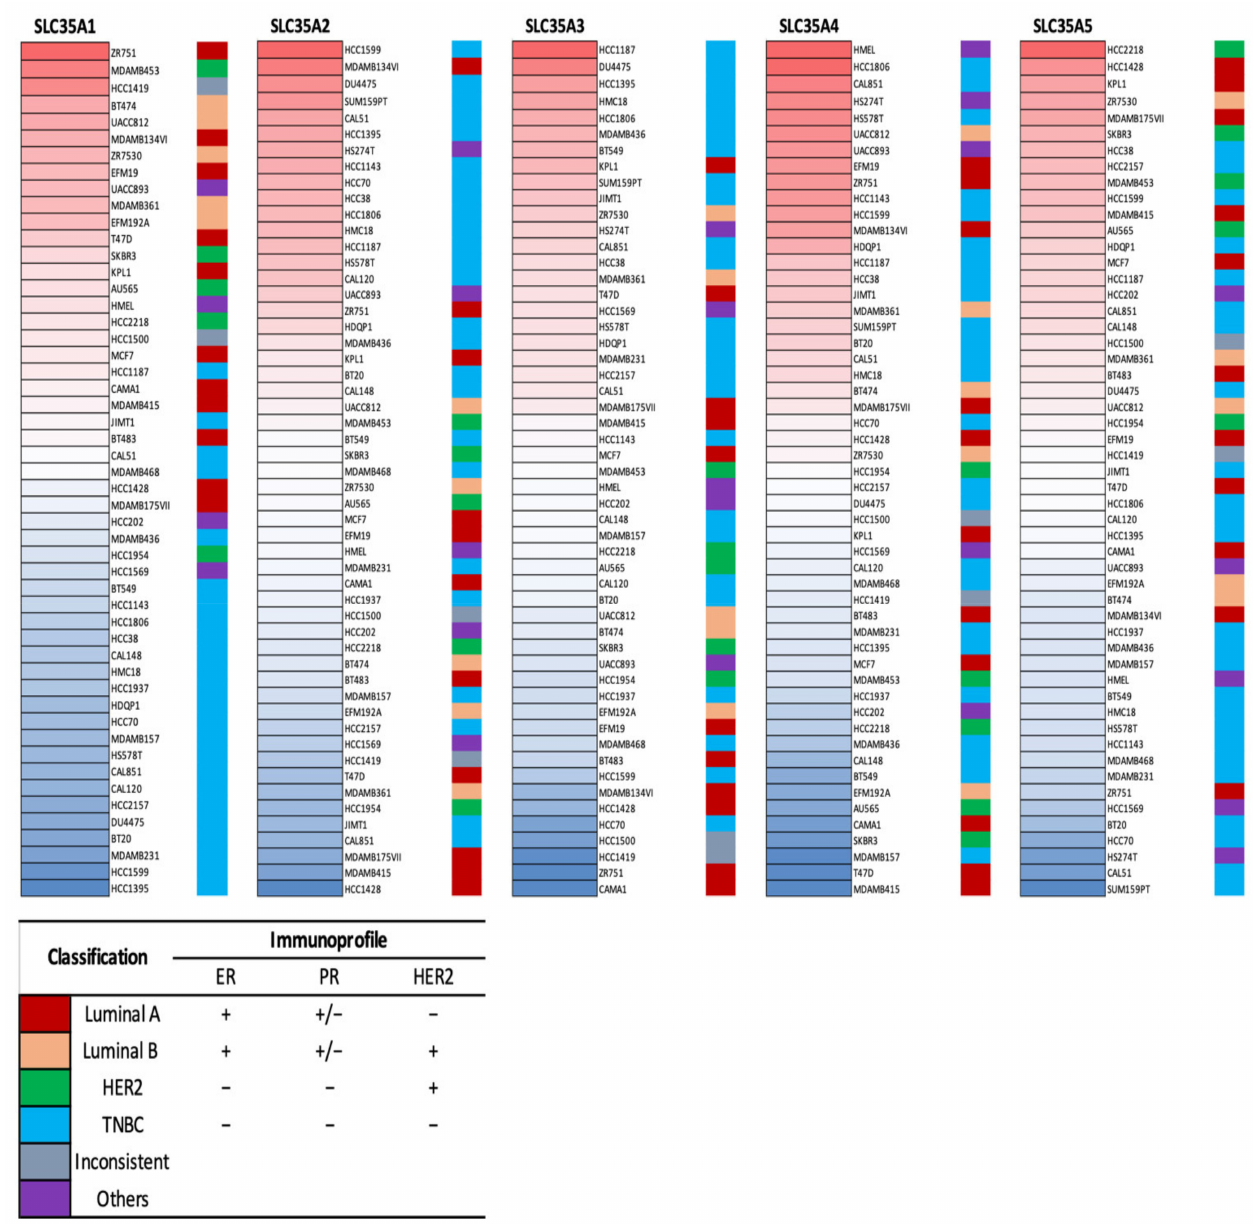
Figure 3. Heatmap of solute carrier 35A (SLC35A) gene mRNA expressions in multiple breast cancer cell lines (CCLE). Data table represented in different colored columns correspond to specific molecular subtype of each cell line. The term “inconsistent” refers to cell lines which were inconsistently annotated in terms of the marker status. “Others” include two non-breast cancer cell lines (HS274T, breast fibroblasts, and HMEL, engineered breast cells). TNBC stands for triple-negative breast